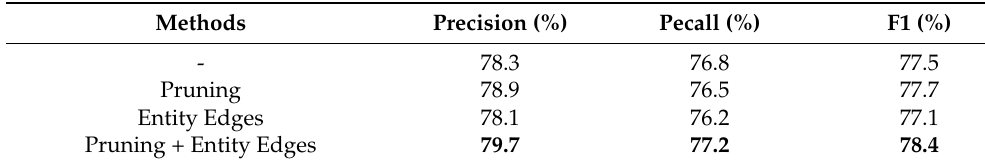
Table 3. Influence of different graph structures on the